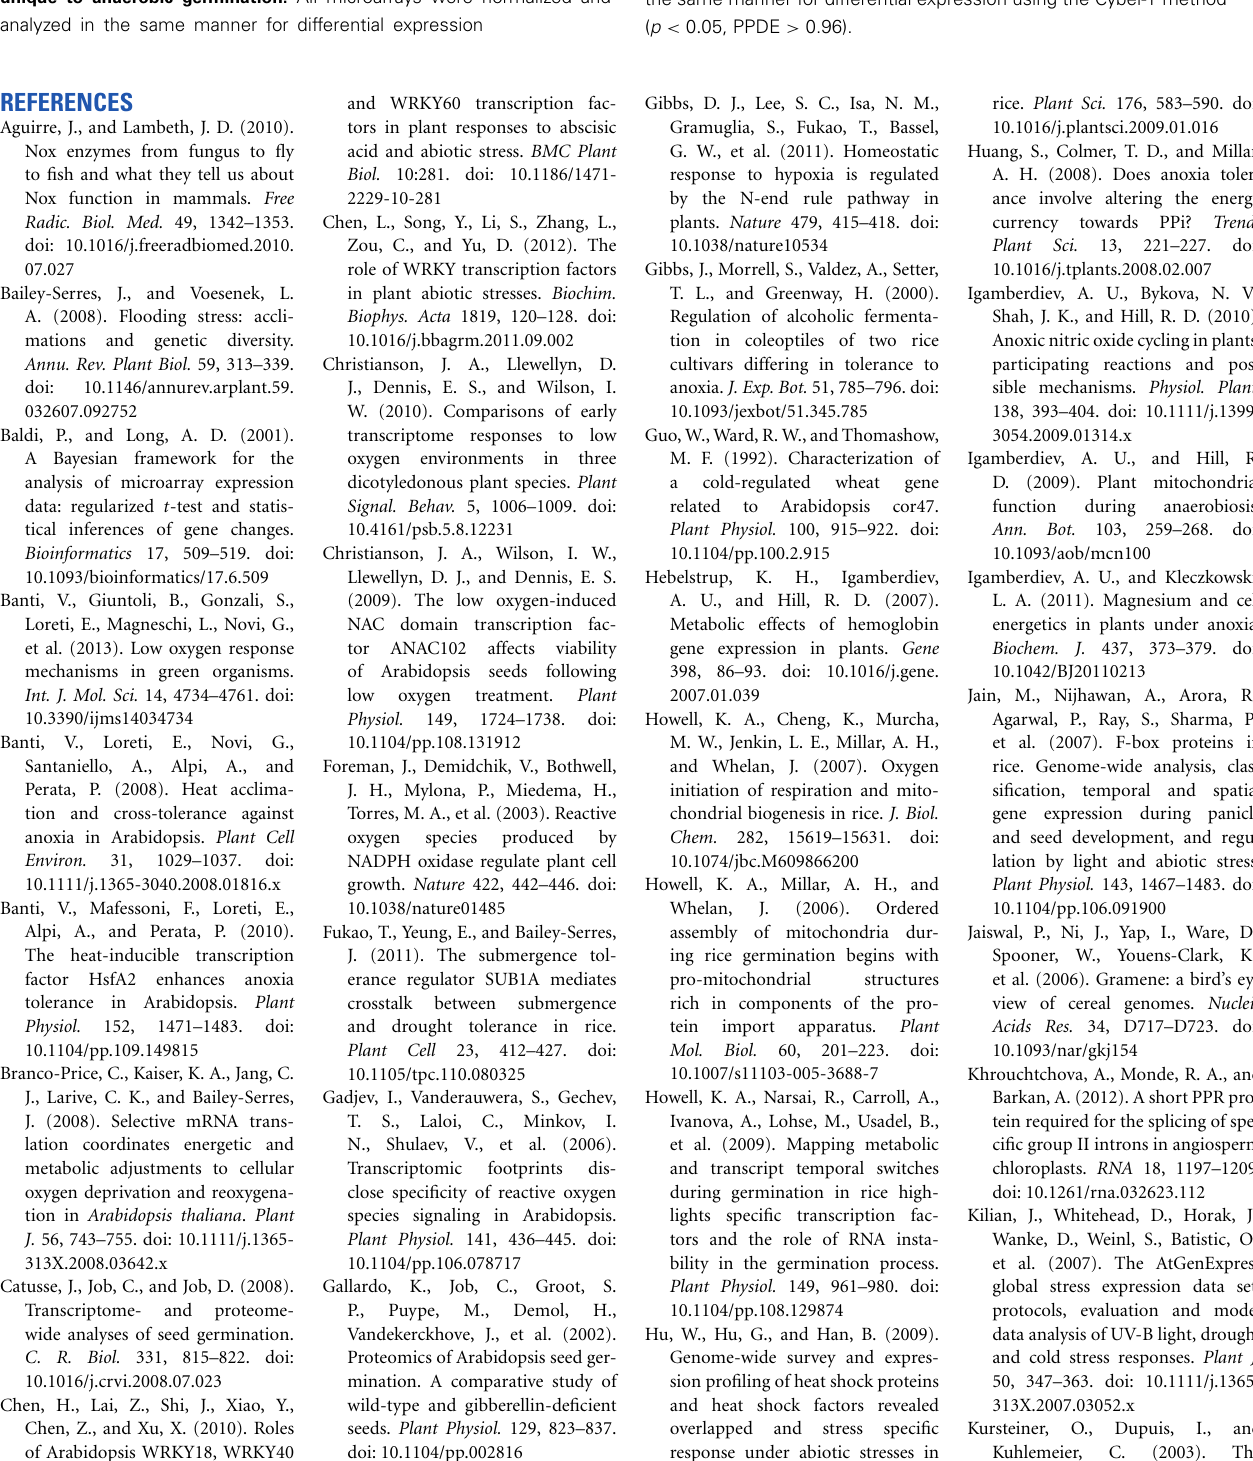
Supplementary Table 5 | Pageman analysis (ORA Fisher using 2.0 as a cut-off) of rice aerobic vs. anaerobic germination, as well as step-wise germination was carried out to show represented functional categories unique to anaerobic germination. All microarrays were normalized and analyzed in the same manner for differential expression